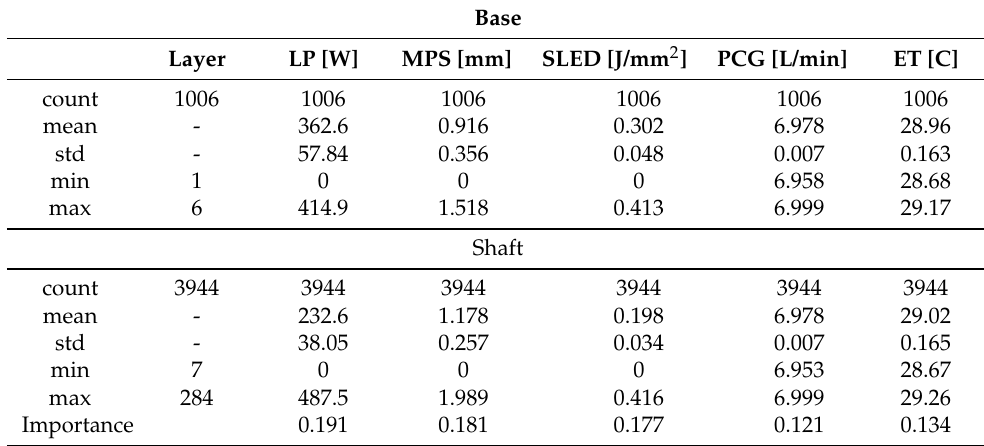
Figure 12. Visualization of features of build of ( a ) LP, ( b ) MPS, and ( c ) SLED. Table 4. Comparison of feature throughout